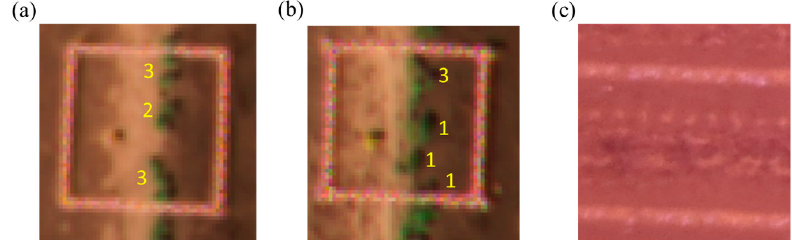
Figure 14. PVC pipe squares and seedlings in multispectral images taken at 15 days after planting in the test field at 30 m AGL with Micasense RedEdge-M ( a – b , shown as RGB channels) and ( c ) at 15 m AGL with XNiteCanonElph130. Images show that misalignment and low resolution make it challenging to evaluate seedling vigor and stand count using multispectral images. The yellow text in (a–b) shows the number of cotton seedling s which were counted visually in field.